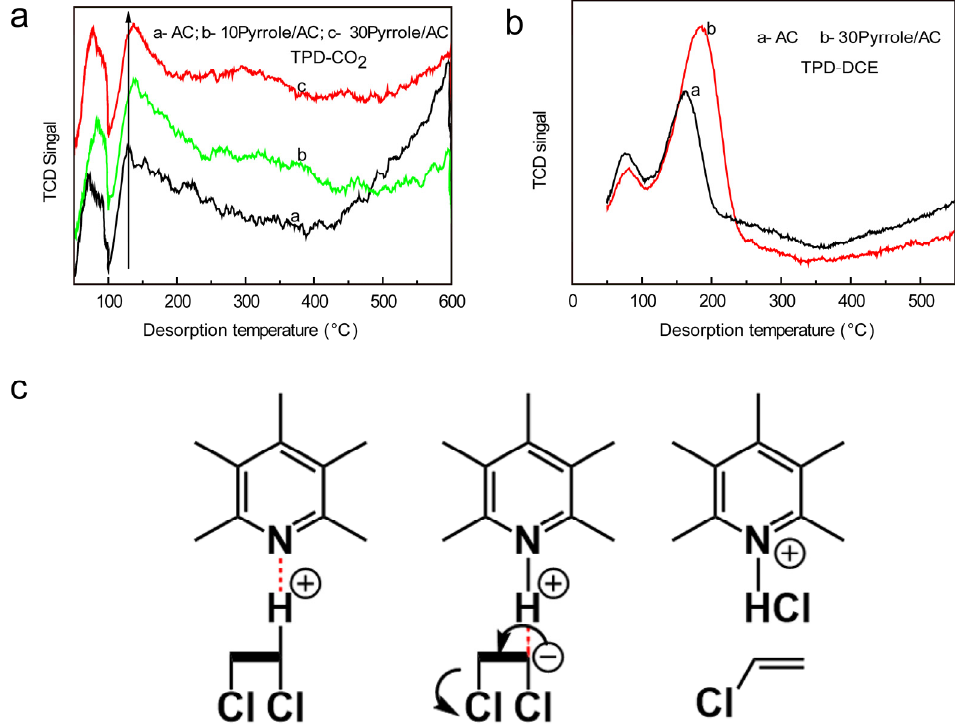
Figure 4. ( a ) CO 2 -TPD profiles of AC, 10Pyrrole/AC, and 30 Pyrrole/AC. ( b ) DCE -TPD profiles of AC and 30Pyrrole/AC. ( c ) Proposed reaction mechanism for DCE dehydrochlorination over N@AC catalysts. Reaction conditions: 260 °C, LHSV 0.5 h − 1 , 1 atm.